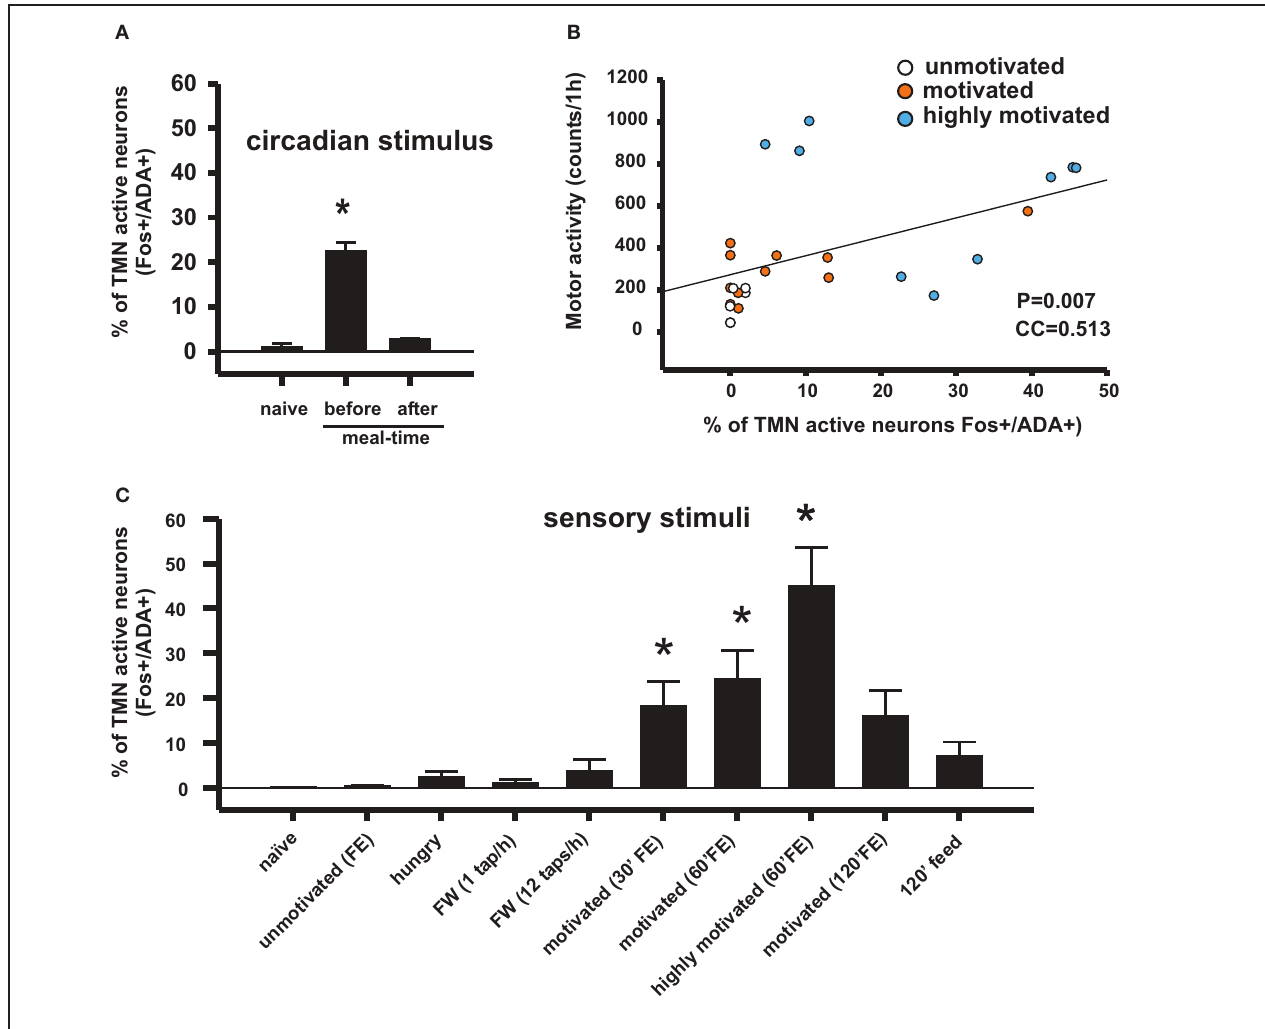
enticing with food. This type of motor activity is used as an arousal index. The Pearson product moment correlation (Valdes et al., 2010). (C) Percentage of histaminergic neurons that became active (Fos-ir/ADA-ir) during different conditions that may induce arousal. Kruskal–Wallis One-Way ANOVA followed by multiple comparisons (Dunn’s method) versus the naive group; ∗ p < 0 . 05. FE, food enticing; FW, forced wake induced by tapping the rat’s